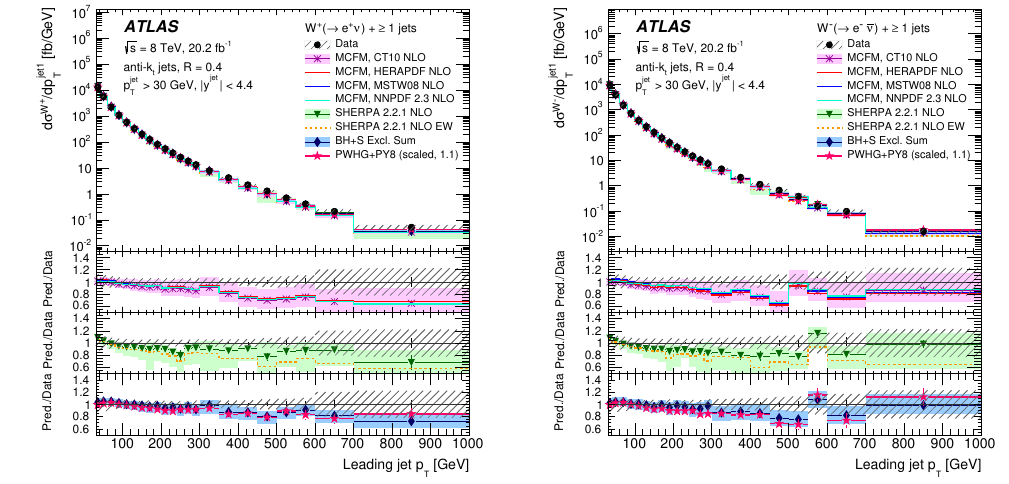
Figure 23 . Di(cid:11)erential cross sections for the production of W + (left) and W (cid:0) (right) as a function of the leading jet p T for events with N jets (cid:21) 1. For the data, the statistical uncertainties are indicated as vertical bars, and the combined statistical and systematic uncertainties are shown by the hatched bands. The uppermost panel in each plot shows the di(cid:11)erential cross sections, while the lower panels show the ratios of the predictions to the data. The theoretical uncertainties on the predictions are described in the text. The arrows on the lower panels indicate points that are outside the displayed